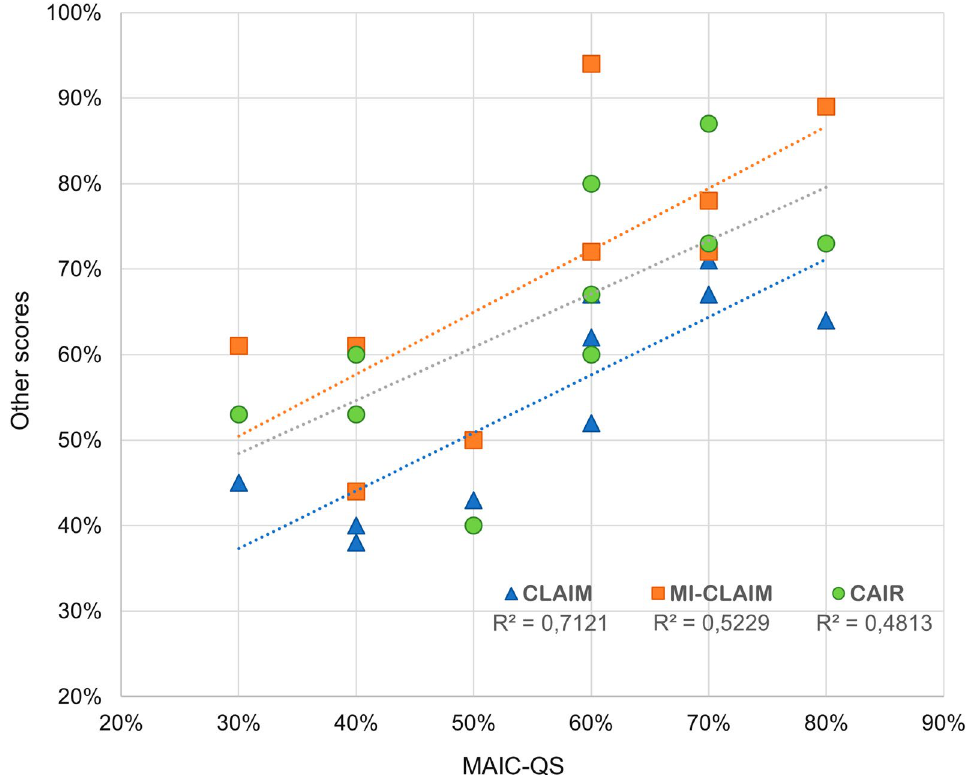
Fig. 1 Quality scores obtained for the 10 selected articles using each of the four compared checklists. MAIC‑QS is shown in the X‑axis and correlations to CLAIM, MI‑CLAIM, and CAIR‑calculated scores are indicated. Quality scores are detailed in Additional file